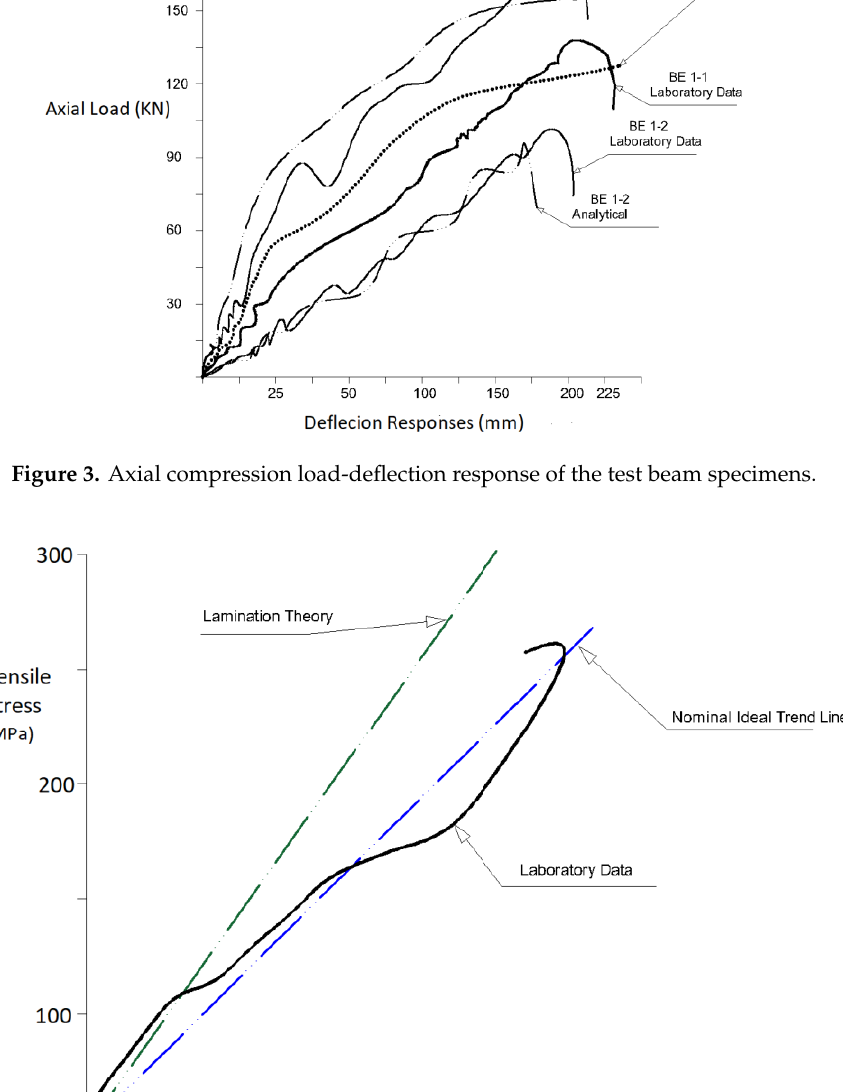
Figure 4. Comparison of axial stress–strain based on laboratory data, the lamination theory, and an ideal hypothetical line. The GFRP material properties are as shown in Table 2, compressive strength of the concrete in the pile: 30 MPa.